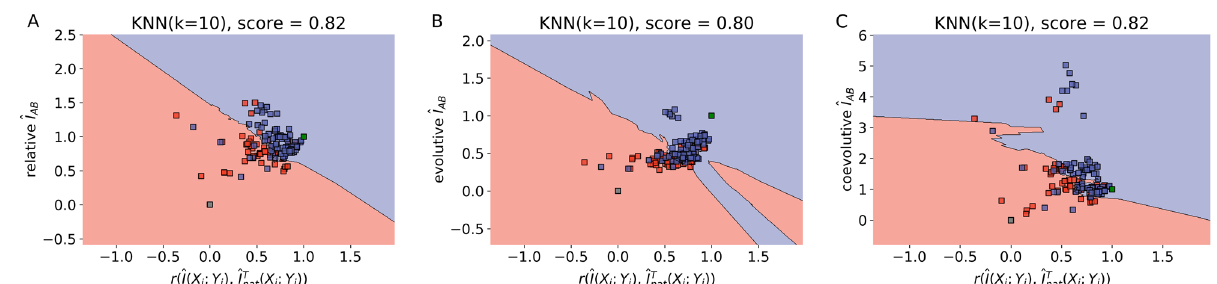
Figure 4. ( A ) Optimized concatenation solutions scattered across the space of relative interface mutual information (MI), ˆ I AB , against Pearson correlation between optimized and native MI vectors, X i ; Y i )) . Type-(i) solutions are shown in red and type-(ii) solutions are shown in blue. The r ( ˆ I ( X i ; Y i ) , ˆ I T nat ( bidimensional space was separated by a k-nearest neighbors (KNN) classification algorithm 16 (default Python 3 scikit-learn implementation, k = 10, for other k values see Figure S2). Native and scrambled concatenations were plotted afterwards in the same space and are shown in green and gray, respectively. Analogous plots were generated for the evolutive ( B ) and coevolutive ( C ) components of ˆ I AB . The decomposition was performed according to 15 . This figure was generated using sci-kit learn v0.22.2 (https:// scikit- learn. org) and mlxtend v0.18.0 (http:// rasbt. github. io/ mlxte